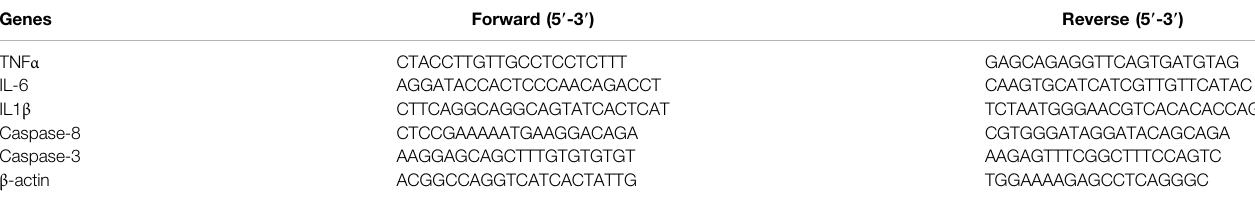
TABLE 1 | PCR primer sequences and target